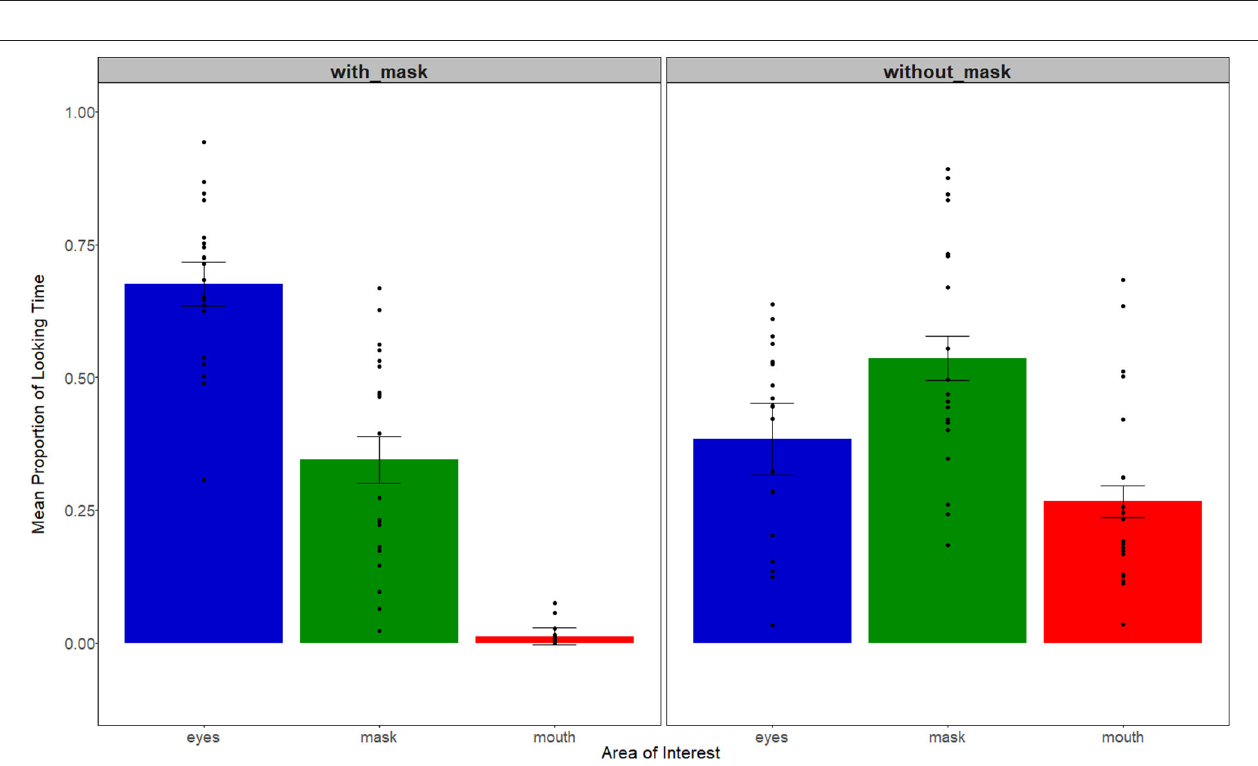
FIGURE 7 | The infants’ mean proportion of looking time to the eyes, mask, and mouth across the two mask conditions during the familiarization phase. Dots represent individual data; error bars + /– 1 standard error of mean.